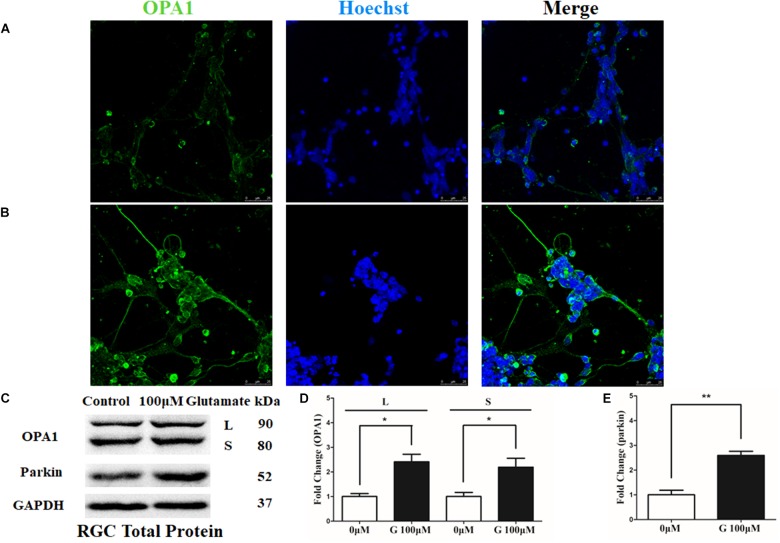
OPA1 expression in cultured RGCs under glutamate excitotoxicity. Compared with the control group (A), increased OPA1 expression was observed in the cell bodies and axons of the RGCs after incubation with 100 μM glutamate (B). Expression of OPA1 and parkin detected by Western blot in the RGCs control and 100 μM glutamate groups (C–E). Compared with the control group, increased expression of the isoforms L and S of the OPA1 protein (C,D) and parkin protein were observed. n = 3, data are expressed as mean ± SD, ∗p < 0.05, ∗∗P < 0.01 compared with the control group. Scale bar = 25 μm (A,B).